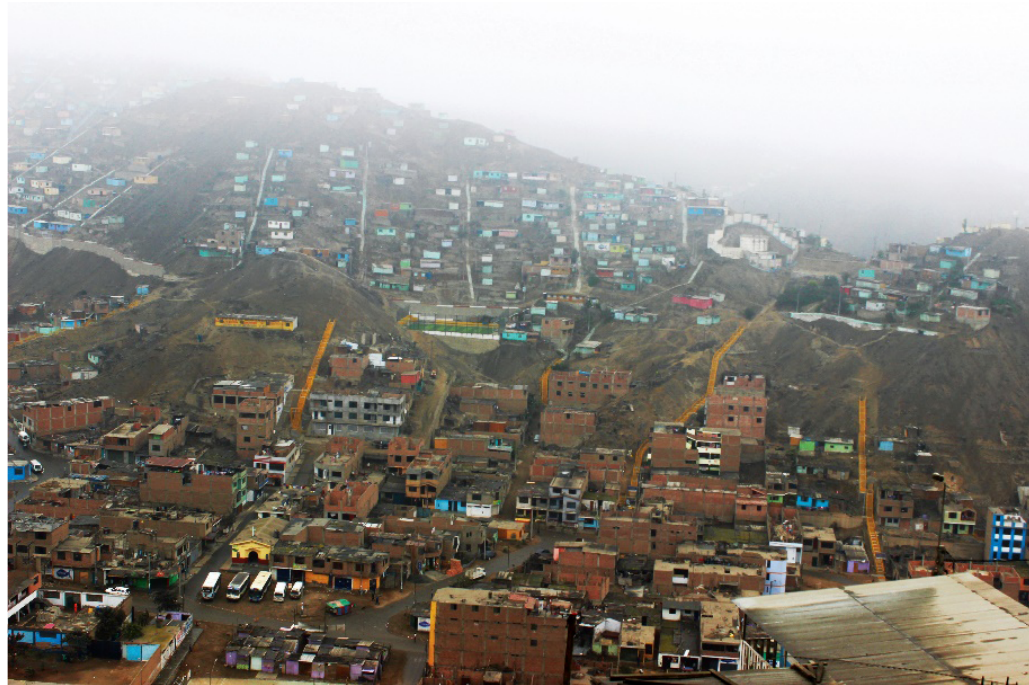
Figure 2. A view of Valle Amauta. Source: Authors. tivities as well as contextual and spatial variables. The variables of the decision-making process and topography are given, according to the context. The spatial variables of centrality , plot size and Floor Space Index are three variables known to be linked to socio-economic activi- ties (Chiaradia, Hillier, Schwander, & Wedderburn, 2009;